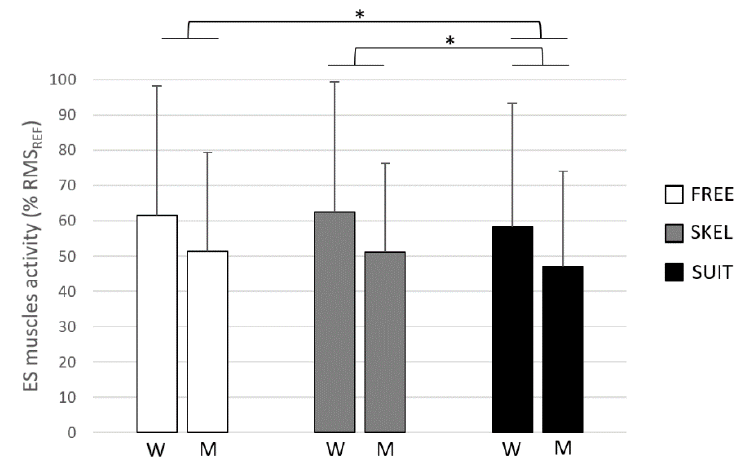
Figure 3. Averaged ES muscles activity (% RMS REF ) and standard deviation in women (W) and men (M), with the use of the rigid exoskeleton (SKEL, gray), the exosuit (SUIT, black), and without equipment (FREE, white). *: significant differences between exoskeletons ( p < 0.05). No interaction between exoskeleton and gender was reported.